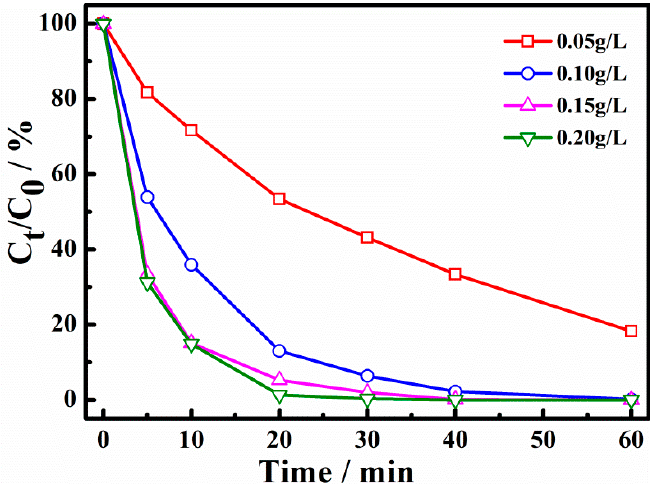
Figure 5. E ff ect of catalyst dosage on degradation of X-3B. Figure 5. Effect of catalyst dosage on degradation of X-3B. Figure 5. Effect of catalyst dosage on degradation of X-3B.